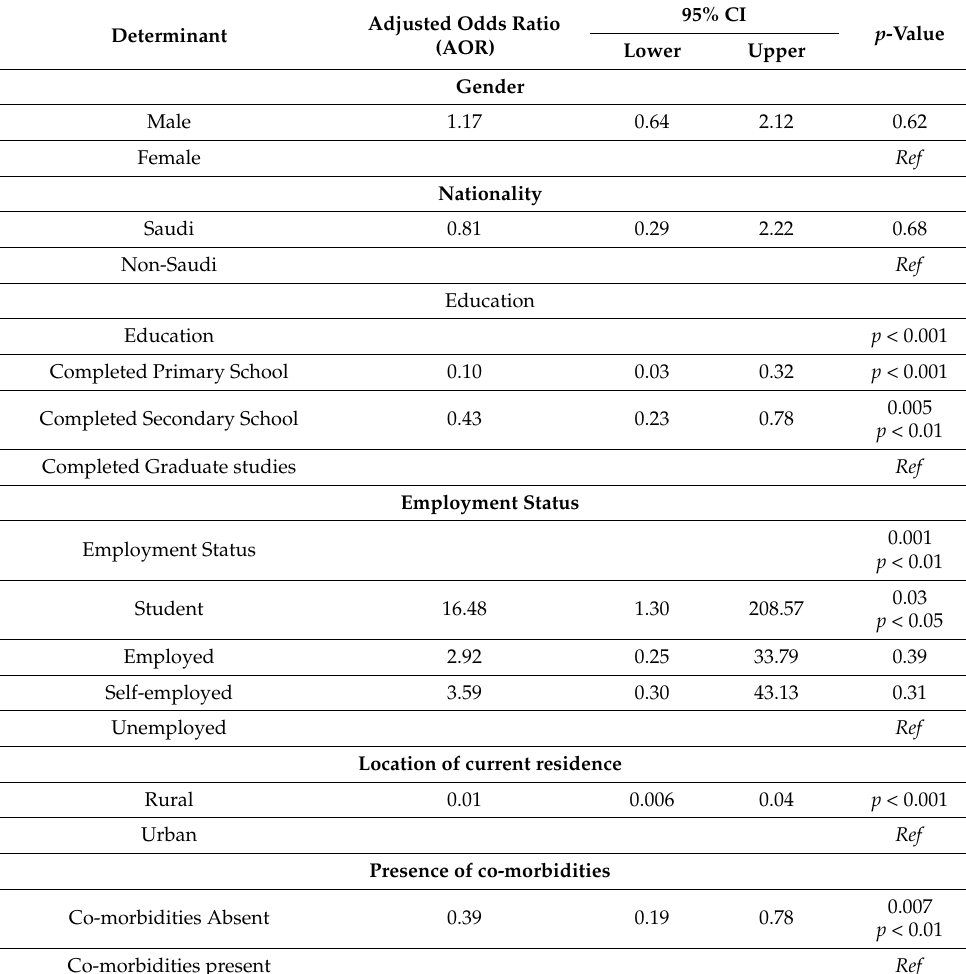
Table 5. Odds of having knowledge related to CKD with selected sample